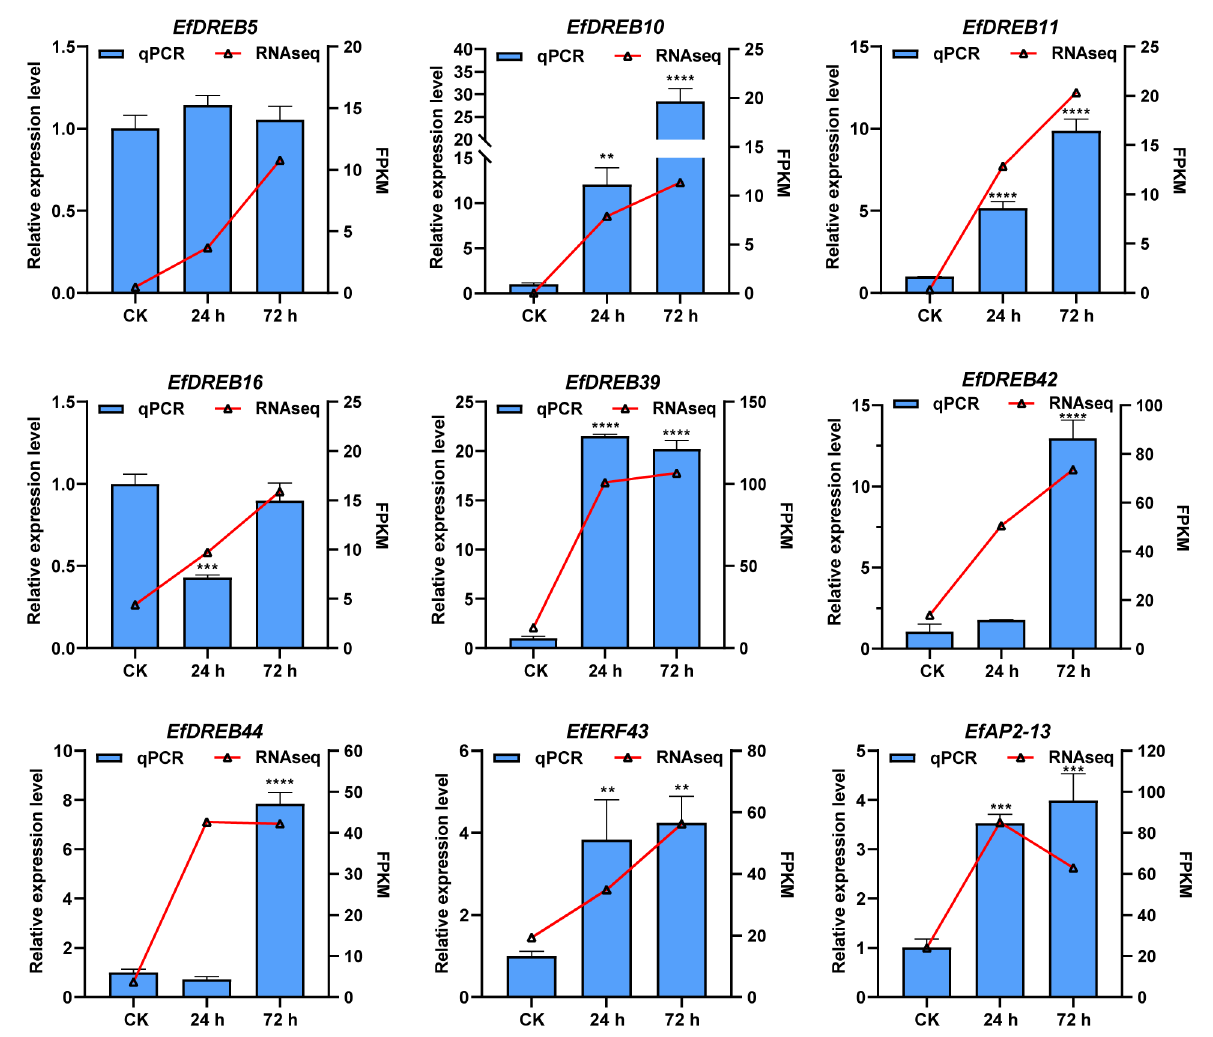
Figure 11. Expression profiles of 9 selected EfAP2/ERF genes in response to cold stress. The 25SRNA gene was used as the internal control gene. Each column represents the mean of three independent replicates. The error bars represent the standard deviations of the mean (mean ± SD). The significant differences relative to controls (one-way ANOVA with Tukey’s multiple range test) are indicated by ** p < 0.01, *** p < 0.001, and **** p < 0.0001. Line charts represent FPKM values of the RNA-seq